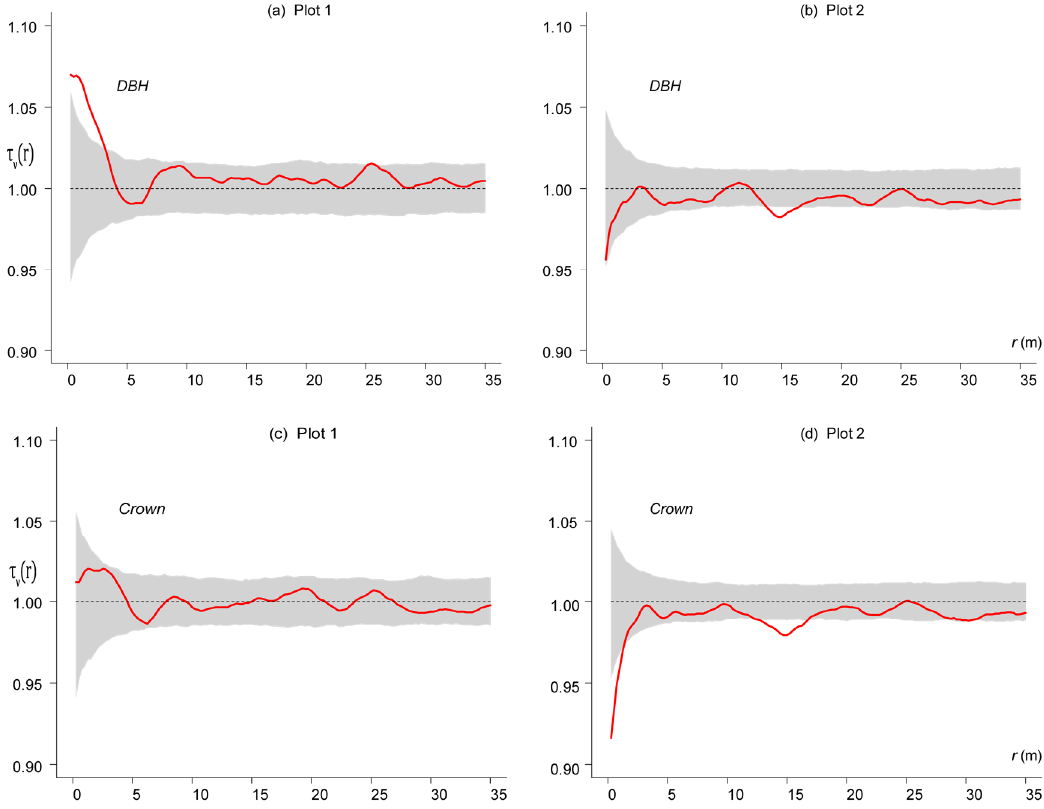
Figure 7. Mark differentiation function of live trees using ( a , b ) tree DBH and ( c , d ) crown size as marks for plots 1 and 2, respectively. Red curves denote the observed mark differentiation function. The envelopes ( grey areas ) denote the range of mark differentiation function of a random assignment of tree size marks, and were constructed from the 2.5% and 97.5% quantiles of 1000 Monte Carlo simulations based on the random labelling null model. Observed lines that fall above the simulation envelops indicate an aggregation of different tree sizes. Observed lines that fall below the simulation envelops indicate an aggregation of similar tree sizes.